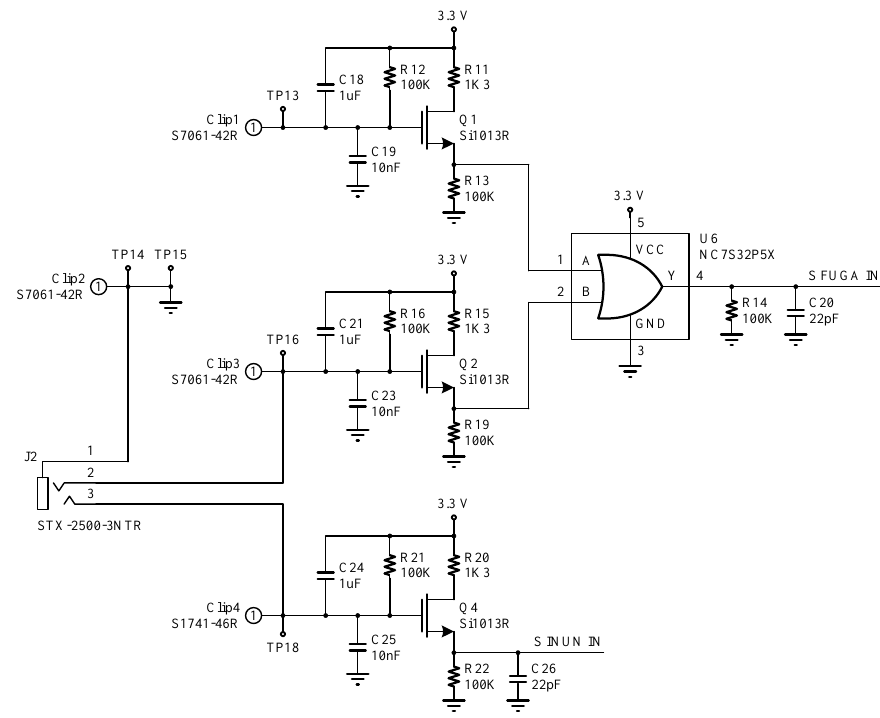
Figure 3. Simplified circuit schematic for the flood sensor.